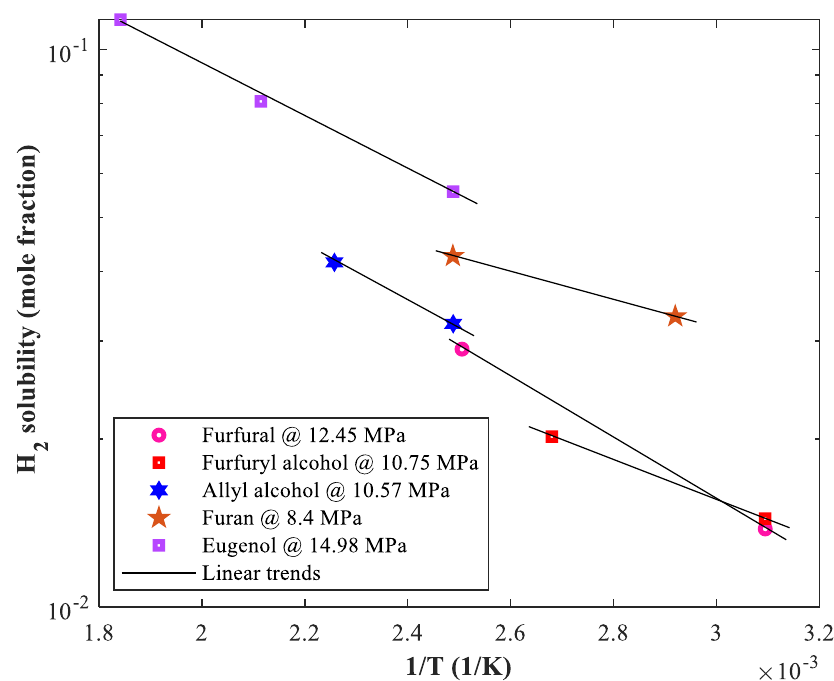
Figure 1. Hydrogen solubility in biomaterials versus working pressure.